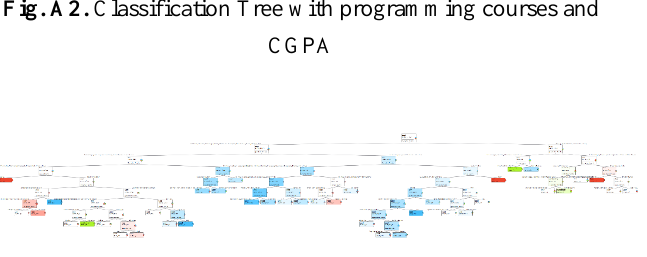
Fig. A3. Classification Tree with family demography